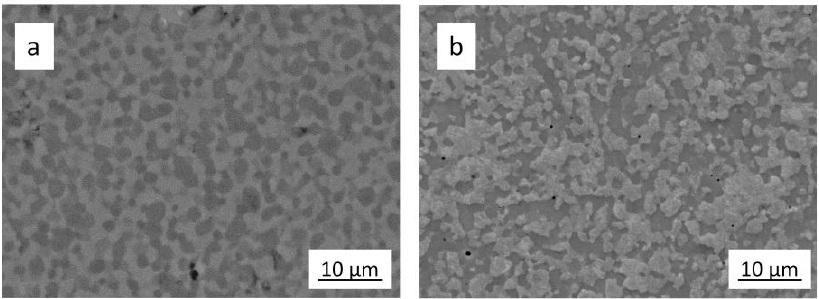
Figure 8. Microstructures of compacts: ( a ) V-9Si-13B and ( b ) Mo-9Si-8B.